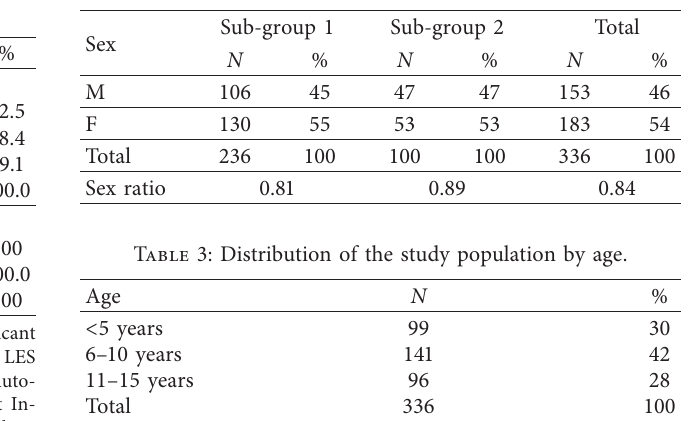
Table 2: Distribution by sex.